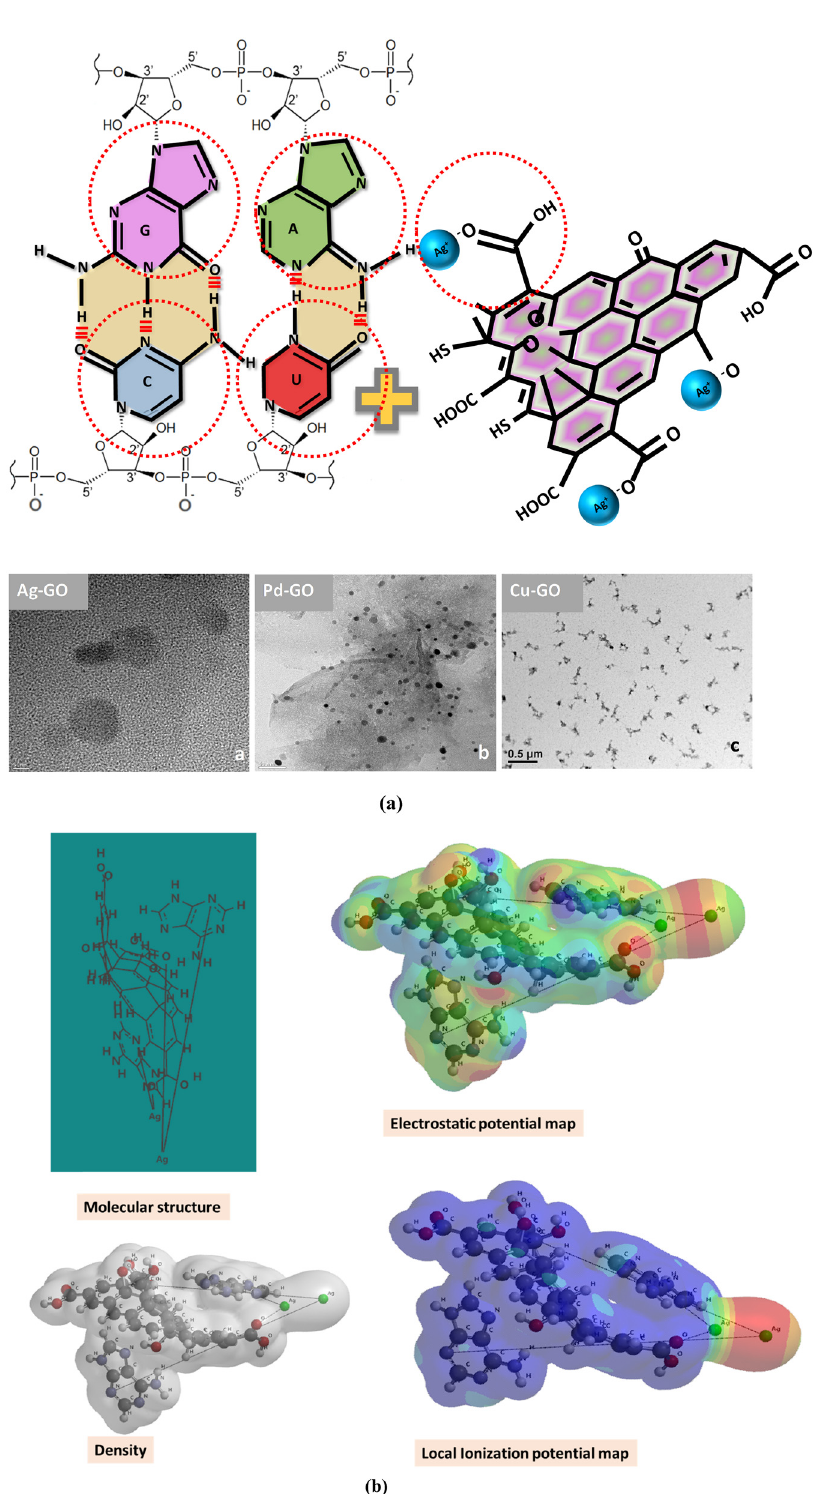
Figure 3: ( a ) Schematic presentation of the synthesis of N9 - propyladenine N1 - oxide with silver possible coordination mode, model structure, and ( b ) electron density, interaction potential, and dynamic simulation of GO, NSH, Ag and GO, Ag and